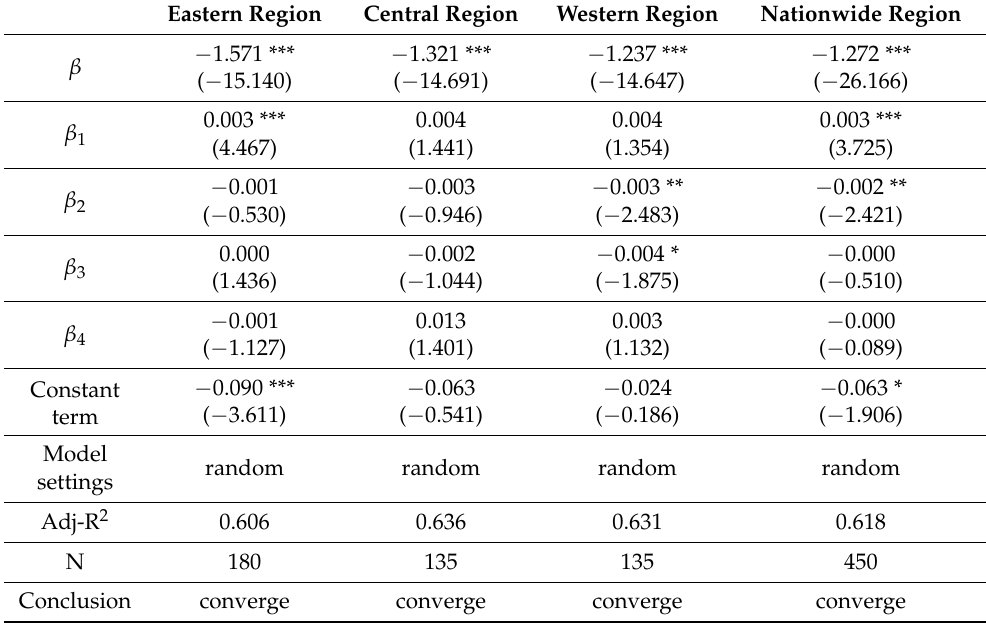
Table 8. Inter-provincial GTFP conditional β convergence test for